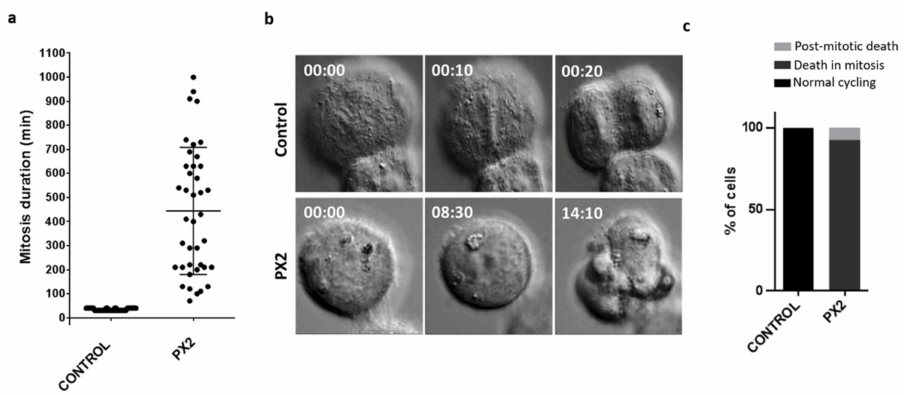
Figure 6. Pyranoxanthone 2 (PX2) treatment promotes death in mitosis, after prolonged arrest. ( a ) Mitosis duration as determined by time-lapse microscopy, in untreated (control) and PX2-treated cells. Each spot represents one cell. ( b ) Representative time-lapse sequences of untreated and PX2-treated cells. Untreated cell undertakes mitosis for about 30 min (top), while PX2-treated cell (bottom) arrests in mitosis during several hours (457.8 ± 264.2 min) followed by death. Numbers indicate times in 00 h:00 min. Movies are available as Supplementary materials. ( c ) Quantification of cell fate after PX2 treatment. The percentage of cells undergoing post-mitotic death (PMD) and death in mitosis (DIM), and cells with normal cycling, over the total number of cells are